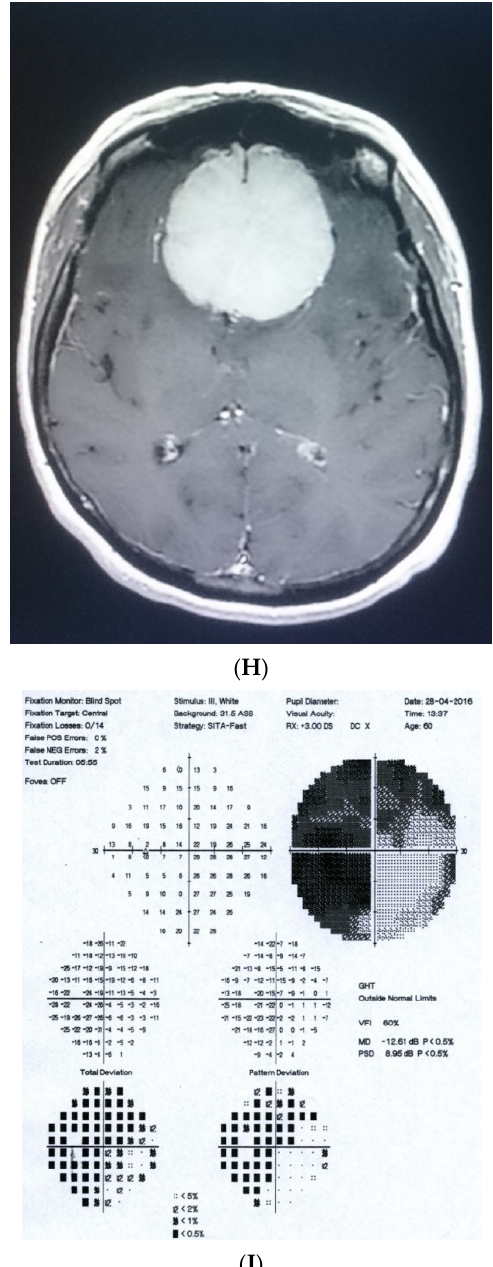
Figure 2: A 56-year-old male treated for POAG with high IOP (30–48 mmHg) for a